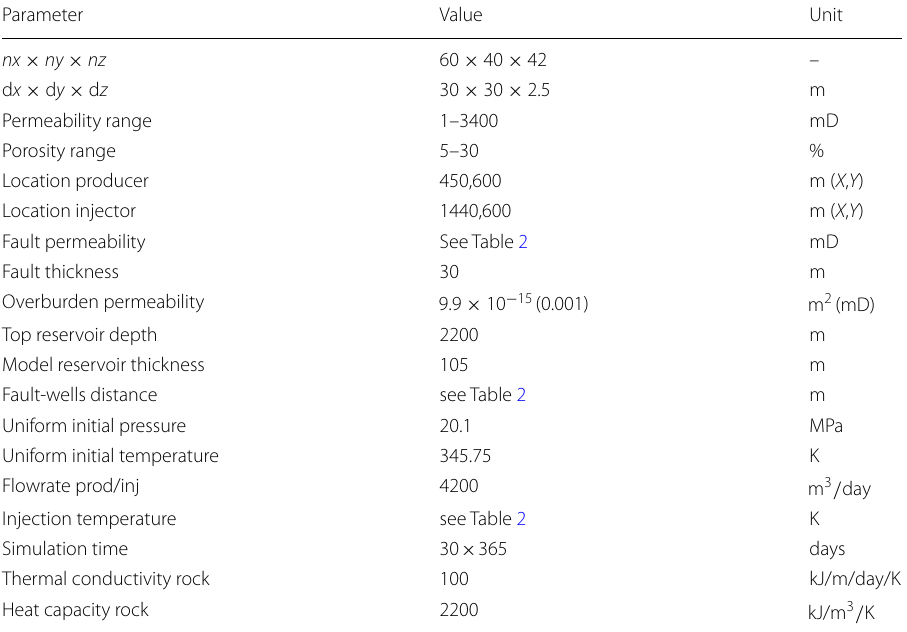
Table 1 Input data for the reservoir